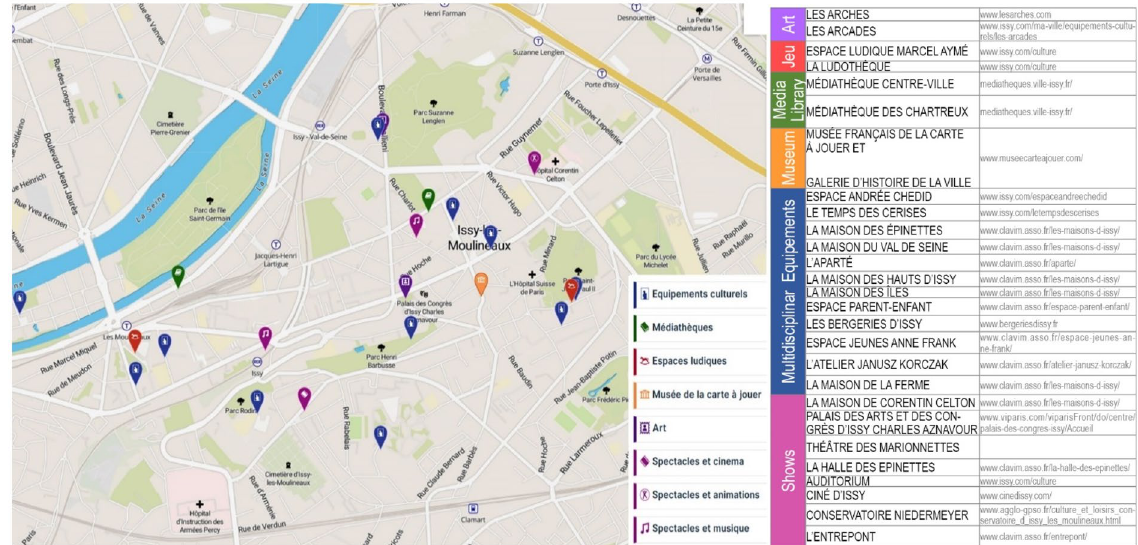
Fig. 3 Localisation of the cultural facilities by typologies. Source: DATA ISSY.COM—Municipality of